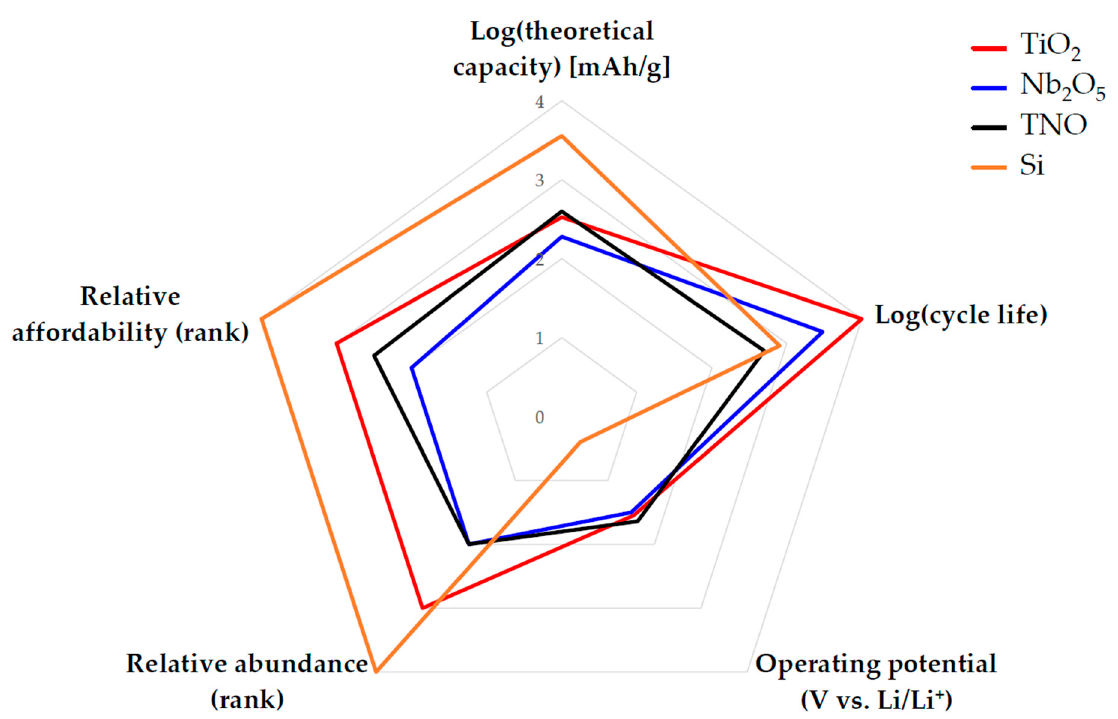
Figure 9. A “spider web” or “radar” chart can comparatively evaluate the complex performance-determining parameters of different materials with greater detail than a Ragone plot. Cycle life and theoretical capacity are plotted on a log scale for clarity. For ranked parameters, higher values indicate higher rank (e.g., Si is relatively the most abundant material of the four selected here).